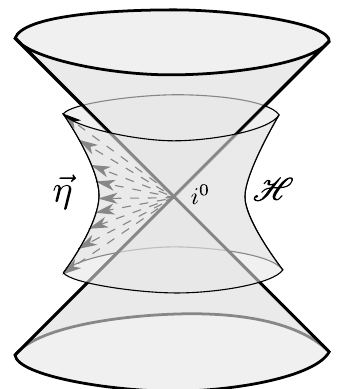
Figure 1 . The unit-hyperboloid H in Ti 0 representing spatial directions ~(cid:17) at i 0 (drawn as dashed rays). Note that H is a non-compact manifold without boundary and we have only drawn a part for